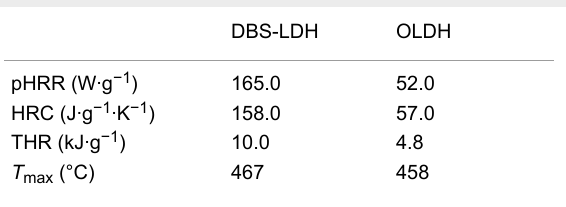
Table 5: Combustion data measured from